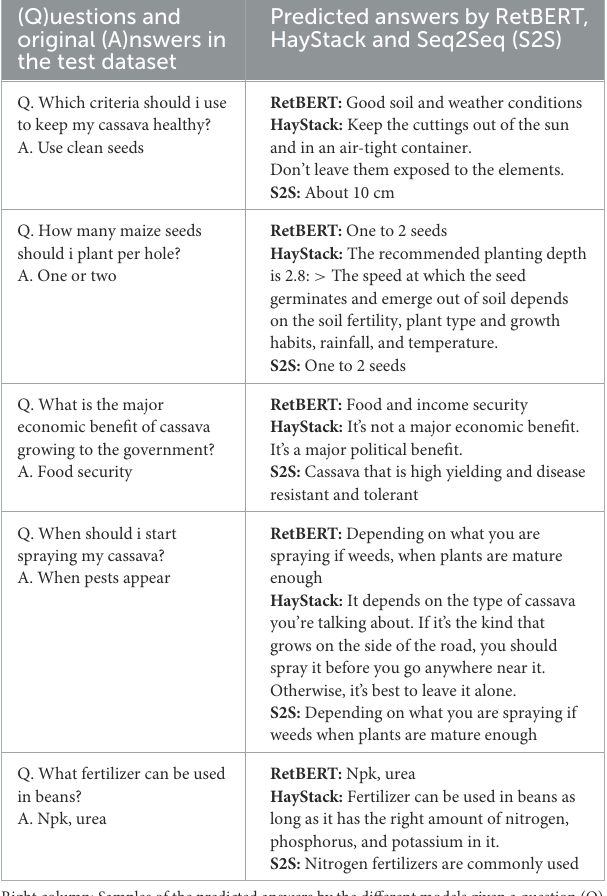
TABLE 3 Left column: Sets of sample questions (Q) and their original answers (A) extracted from the test dataset. (Q)uestions and original (A)nswers